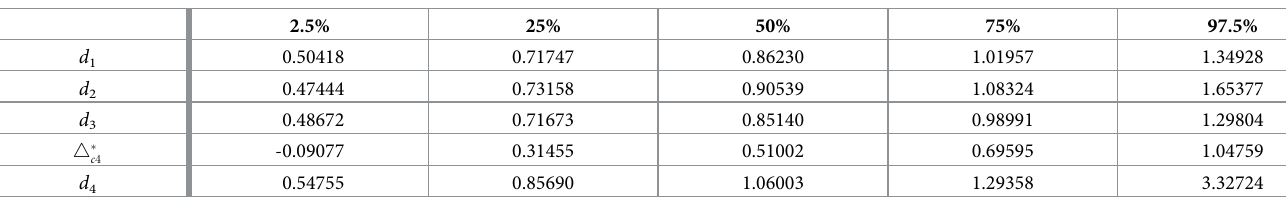
Table 2. Quantiles for each